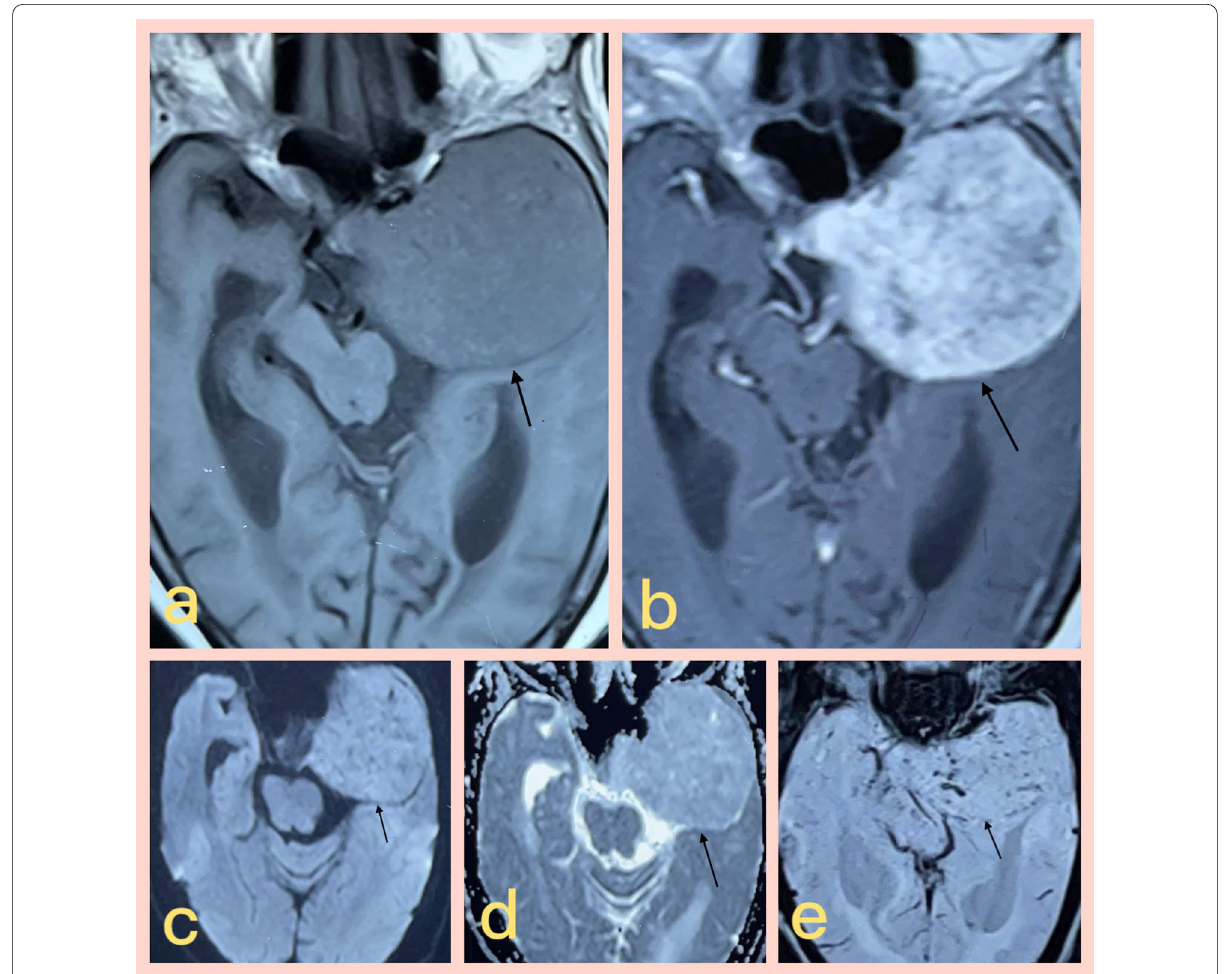
Fig. 2 a Axial T1-weighted non-contrast image shows a isointense-to-hypointense mass in middle cranial fossa in left parasellar region. b Axial T1-weighted post-contrast image shows mass (denoted by black arrow) showing intense heterogeneous enhancement. c Axial DWI image showing no DWI restriction within the mass (denoted by black arrow). d Corresponding ADC image shows no loss of signal within the mass (denoted by black arrow). e Susceptibility-weighted imaging (SWI) showing multiple blooming foci within the mass (denoted by black